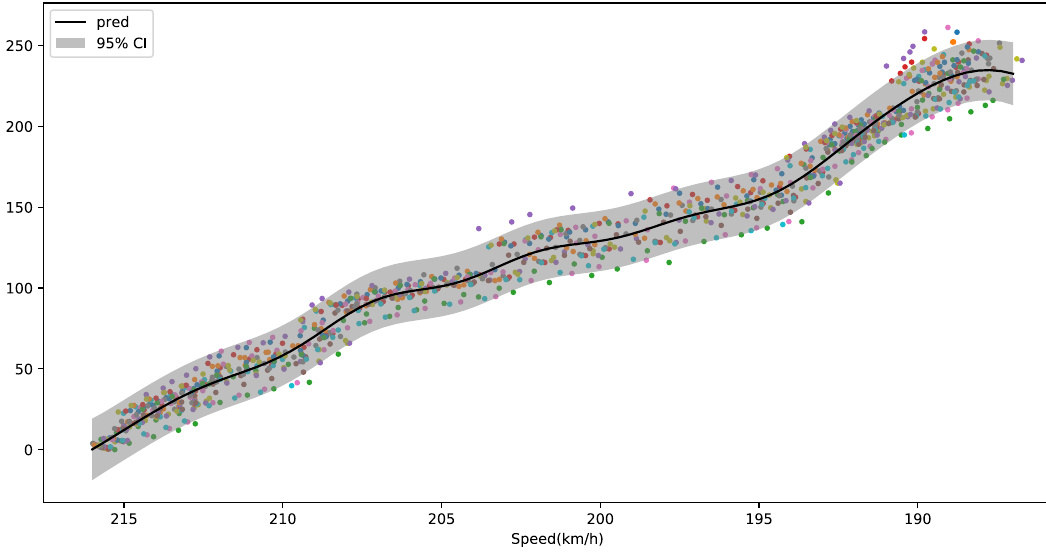
Figure 15. The predicting flight time and its CI with respect to the flight speed (the dots in a different color are extracted from historical trajectories).